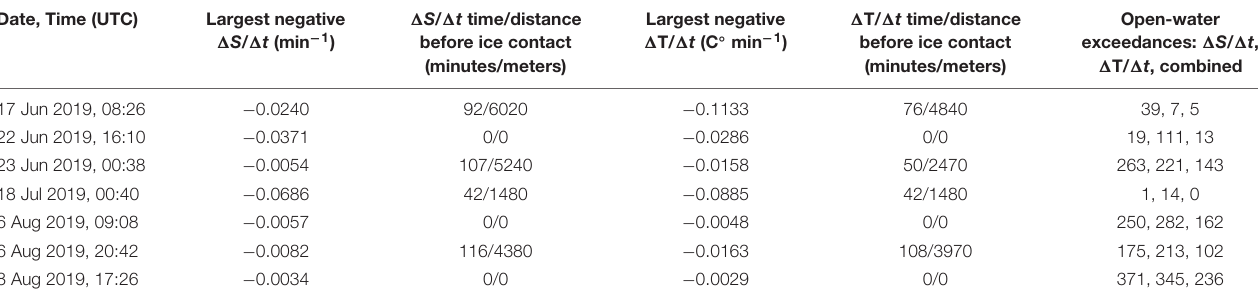
FIGURE 13 | As in Figure 9 , except for sd-1035’s 14 June 2019 ice encounter. In this case a horizontal photo revealing sparse ice was taken at 09:20 and a downward looking photo confirming ice surrounding the vehicle taken at 09:25 UTC. The drop in vehicle speed over ground between 09:25 and 09:26 (upper-left panel; marked by the IBV-vertical black line in each panel) confirms that the vehicle was impeded then. The blue vertical lines in the near surface water temperature plot (lower left) mark the times of the images shown on the right. TABLE 1 | Minimum temperature and salinity tendencies observed during seven 3-h-long sd-1036 transects beginning in open water and ending with an IBV (vehicle blocked by sea